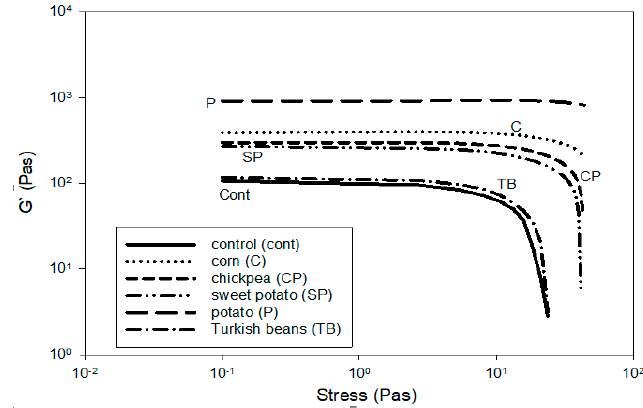
Figure 2. Linear viscoelastic region determination of the control and starch containing yogurt.